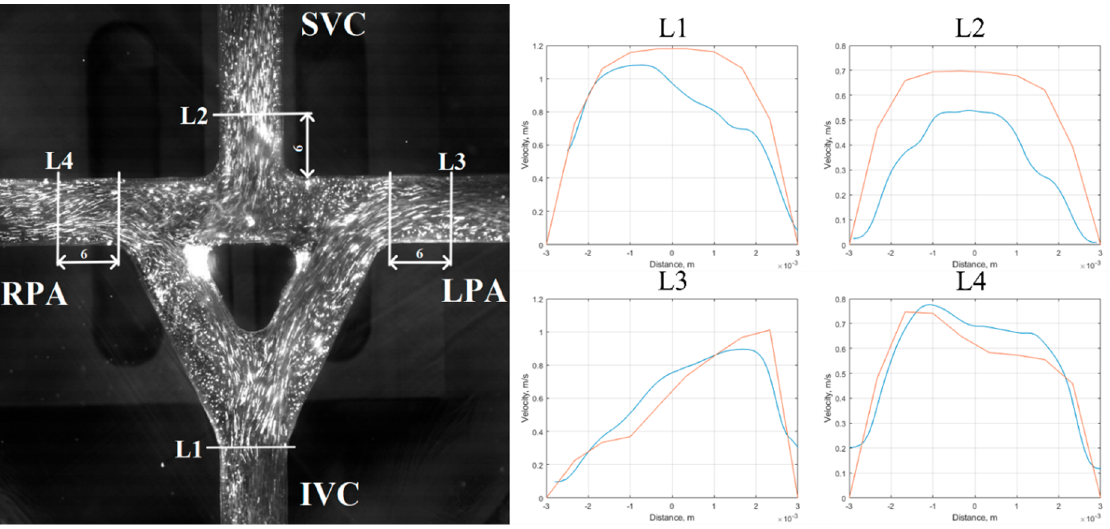
Figure 12. Velocity modulus distribution in various sections for TCPC ‐ 3: red line—CFD modeling, blue line—experimental data. TCPC ‐ 3 has the most correspondence between experimental and CFD results.